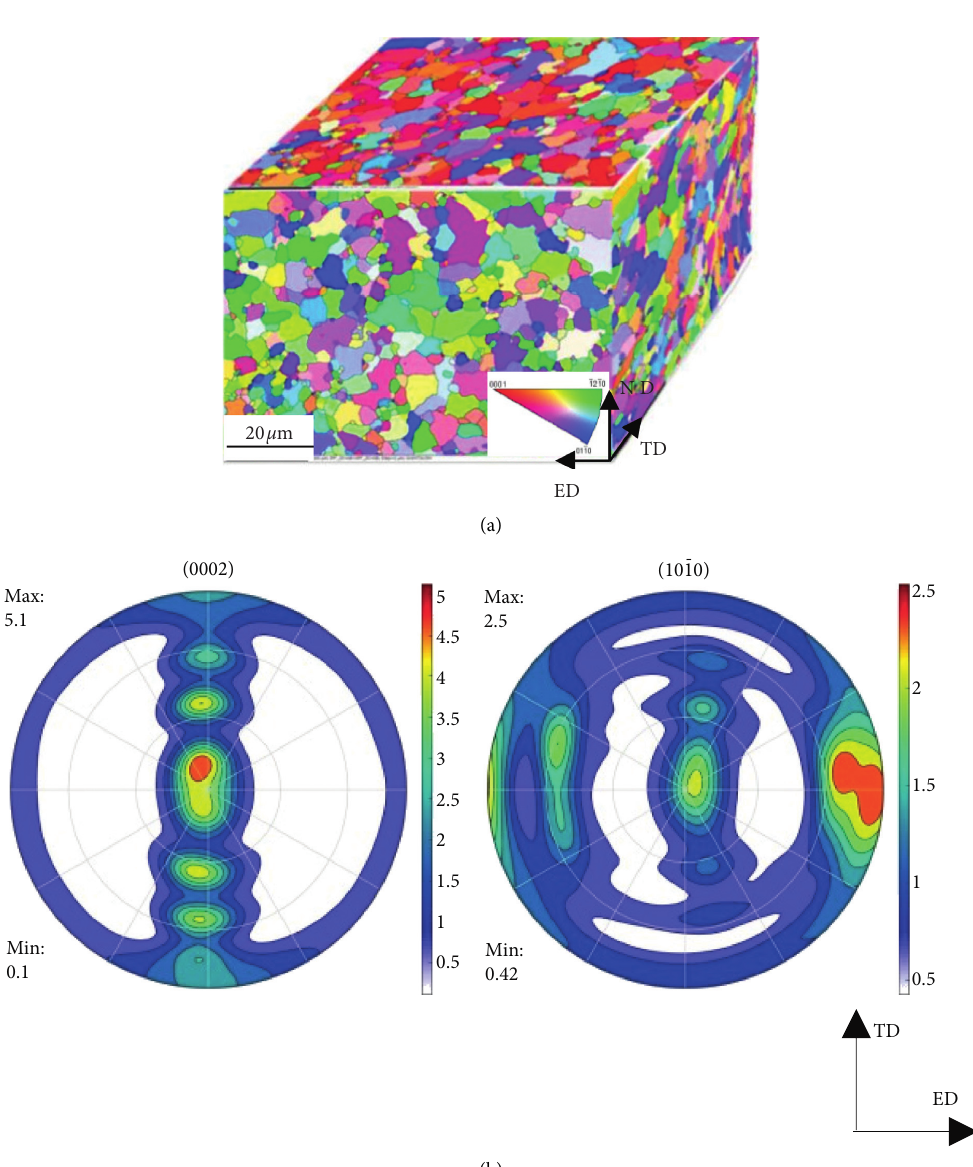
Figure 3: Initial state of MgAZ31 extruded bar: (a) three-dimensional microstructure; (b) initial texture.